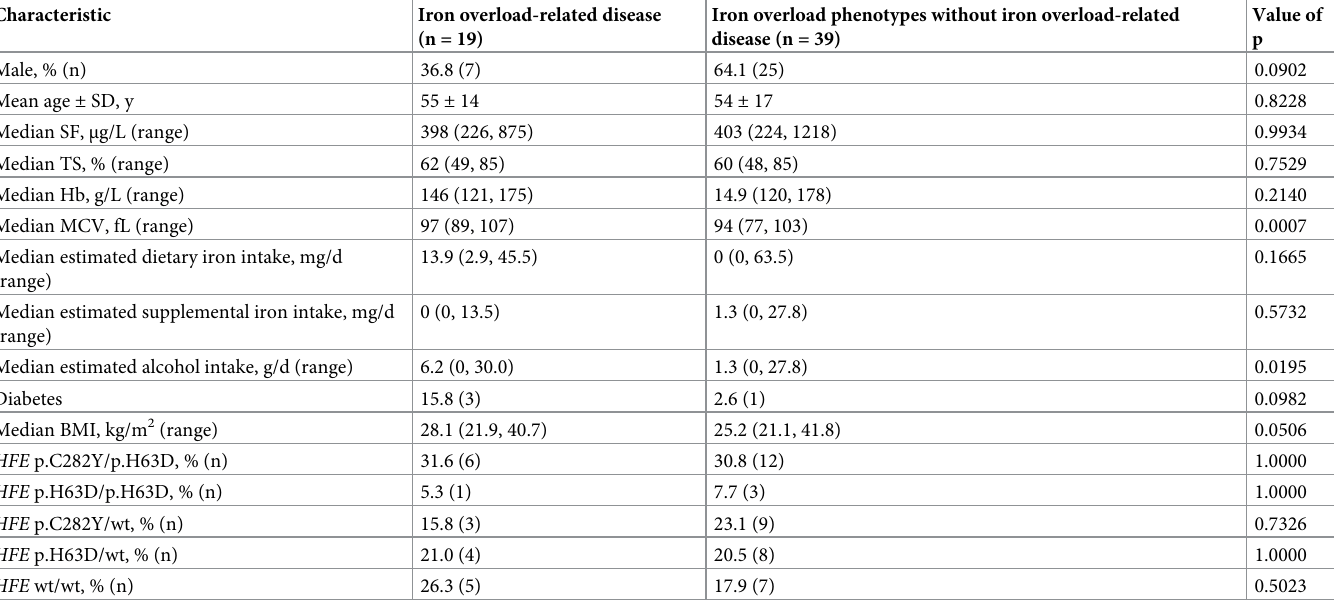
Table 3. Iron overload-related disease in 58 non-Hispanic white post-screening clinical examination participants a .